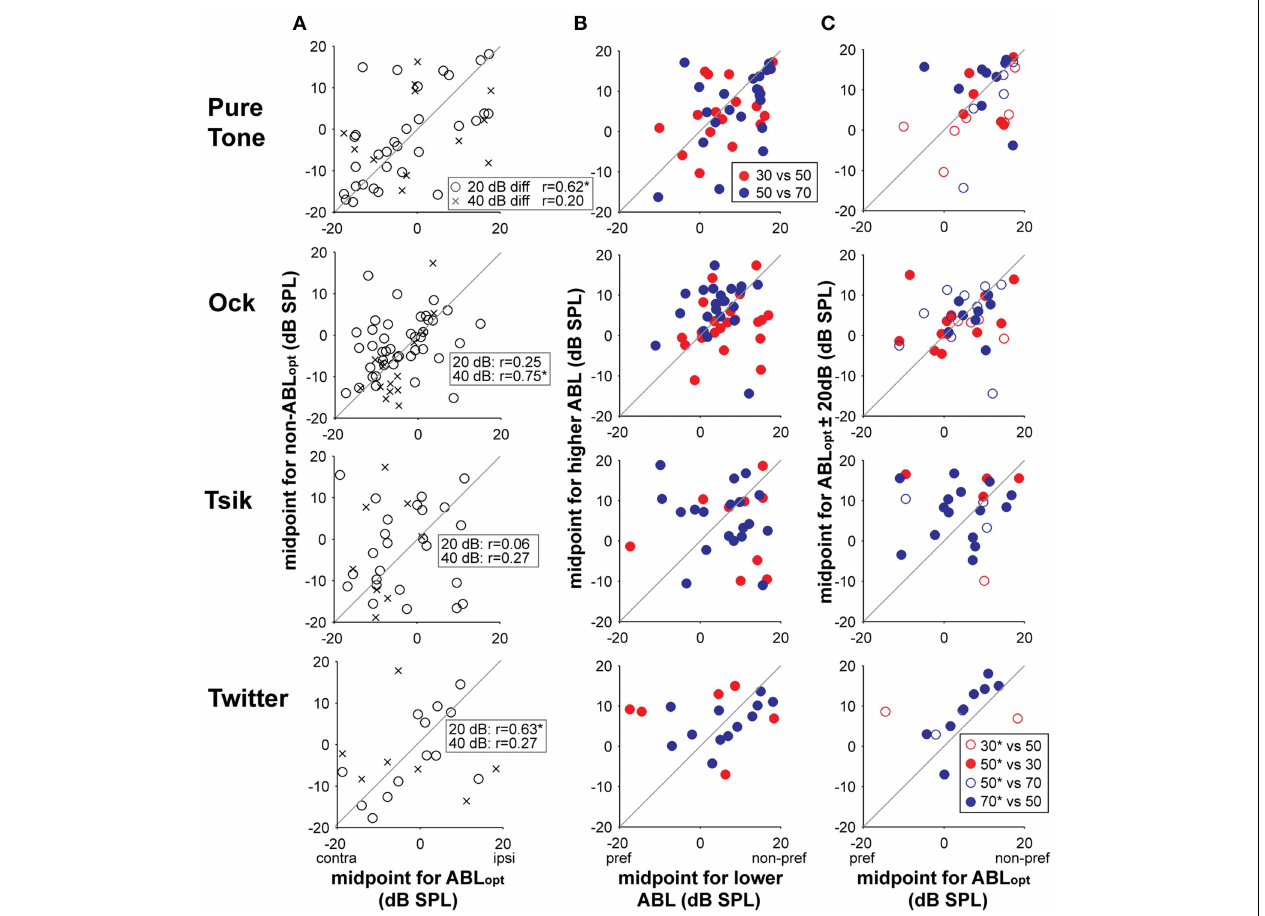
legend denotes the specific intensities of the pair-wise comparisons. Column (C) compares the midpoints relative to the preferred side for optimal intensities (x-axes) with non-optimal intensities (y-axes). Only level-invariant monotonically sensitive cells are shown here. Legend identifies the specific comparisons, * denotes the ABL opt , i.e., open circles are cells which prefer the lower ABL and closed circles are cells that prefer the higher ABL. Different rows show data in response to different stimuli. Abbreviations: contra, contralateral; ipsi, ipsilateral; pref, preferred; non-pref;